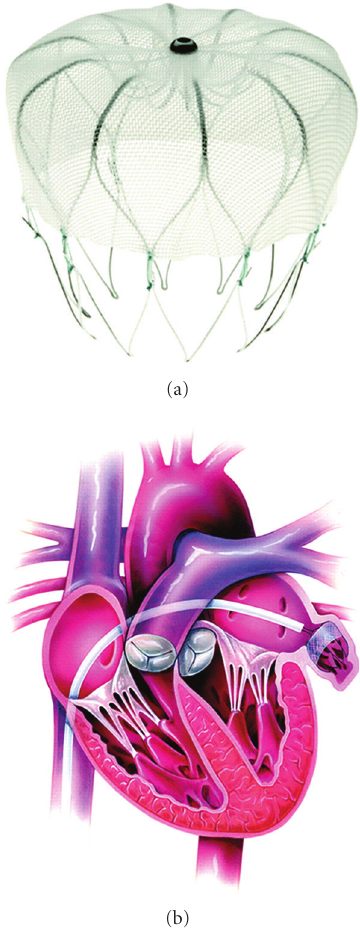
Figure 3: The WATCHMAN LAA Closure Device (a) highlighting the permeable membrane covering its left atrial face and (b) prop- erly deployed within the ostium of the left atrial appendage. ( Image courtesy of BMJ Publishing Group Ltd and British Cardiovascular Society. )